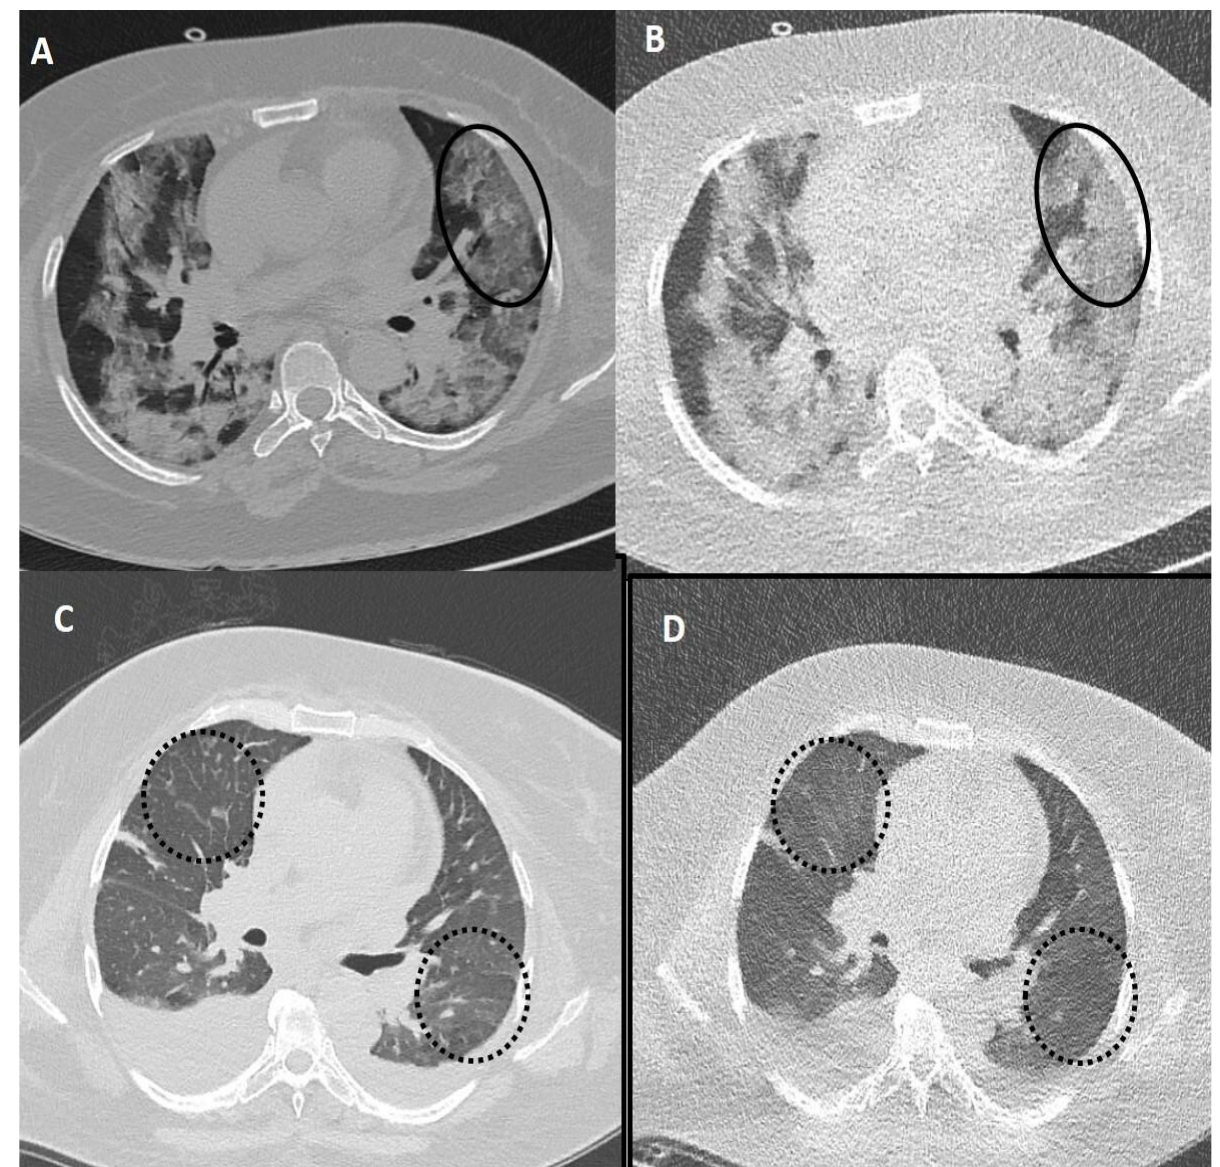
Figure 5. Fallacies of ultra-low dose CT (ULDCT) chest in two different COVID-19 patients: ( A , B ) A 53-years old female patient with SDCT ( A ) showing areas of GGOs in the left lung (black circle) and in the corresponding ULDCT ( B ) these areas of GGO’s were misinterpreted as consolidation (black circle). ( C , D ) SDCT images in another patient ( C ) showing subtle interlobular septal thickening in bilateral lungs (dotted circles) that was missed on the corresponding ULDCT ( D ) images (dotted circles). CT severity score calculated on SDCT and ULDCT, however, was similar in both patients.